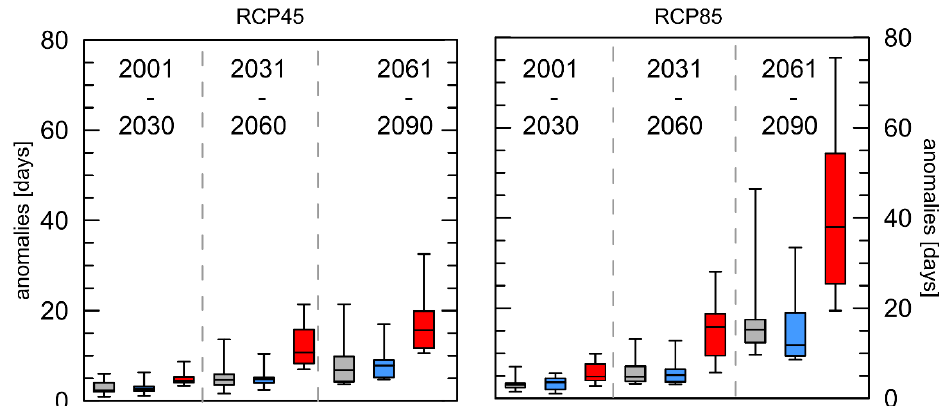
Figure 5. Boxplots of mean anomalies of the length of the longest heat waves each year (HW-D) with reference to the 30-year period 1971–2000 for the three cities London (grey), Luxembourg (blue), and Rome (red) and two different RCPs. Whiskers = 5/95 percentile.